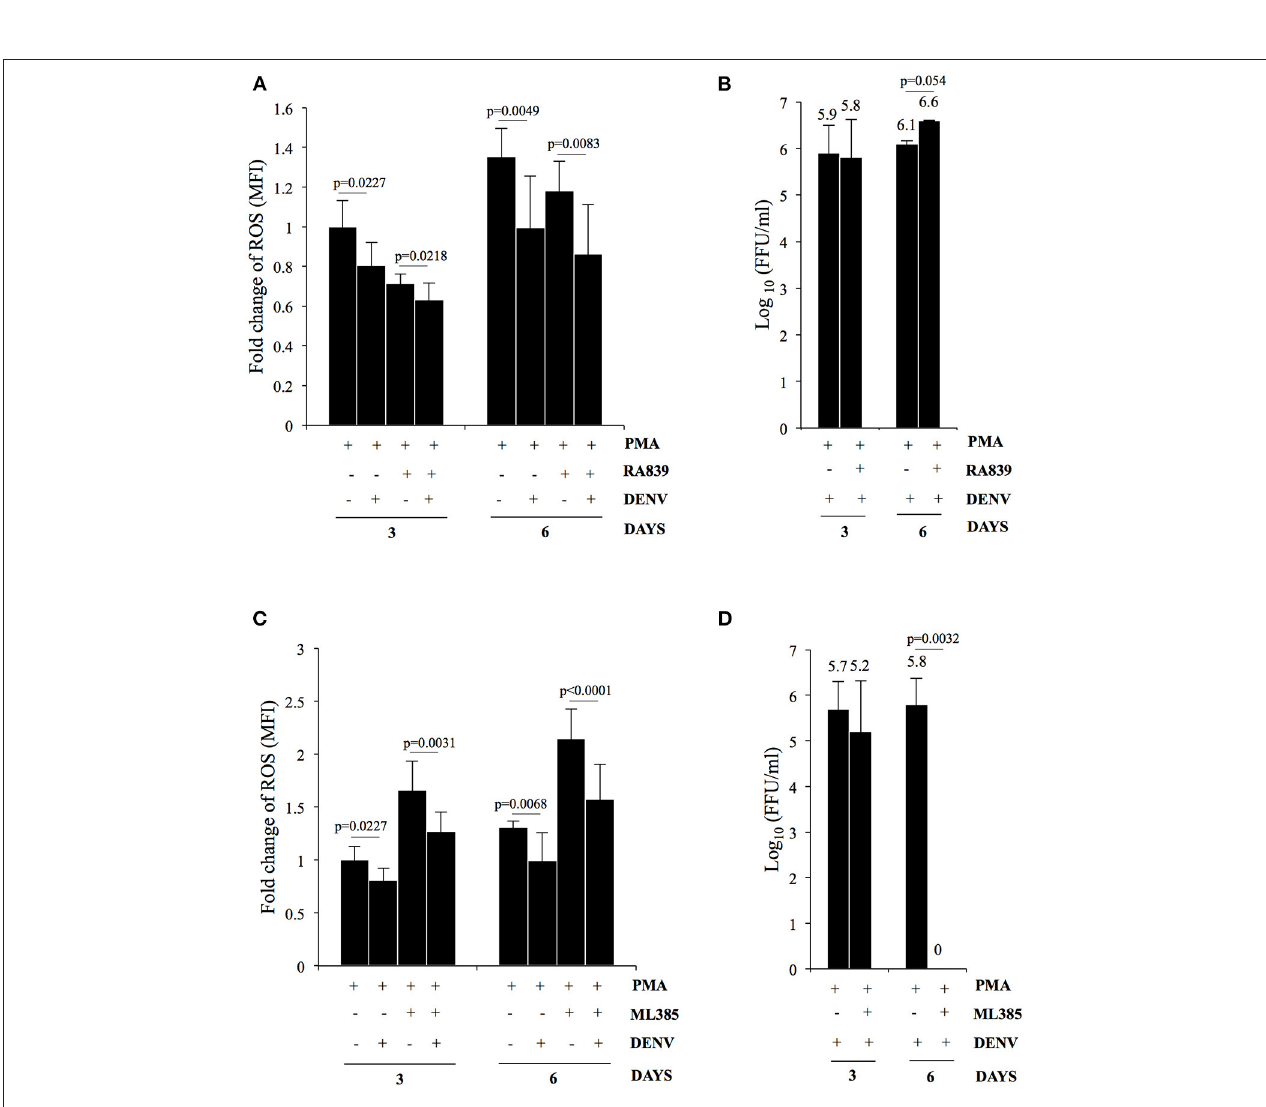
FIGURE 5 | DENV replication suppresses ROS in differentiating cells by upregulation of NFE2L2 activity. (A) K562 cells either uninfected or infected with DENV at an MOI of 1.0 were differentiated with 50nM PMA in the absence or presence of 10 µ M of RA839. At 3 or 6 days post-infection the cytosolic ROS was quantified by H 2 DCFDA staining as described above. (B) K562 cells infected with DENV at an MOI of 1.0 were differentiated with PMA in the absence or presence of 10 µ M of RA839. The supernatant was collected at 3 or 6 days post-infection and the infectious titer of secreted virus quantified by Focus-forming unit (FFU) assay. The Log 10 of the FFU/ml was calculated and plotted. (C) K562 cells either uninfected or infected with DENV at an MOI of 1.0 were differentiated with PMA in the absence or presence of 10 µ M of ML385. At 3 or 6 days post-infection the cytosolic ROS was quantified by H 2 DCFDA staining as described above. (D) K562 cells infected with DENV at an MOI of 1.0 were differentiated with PMA in the absence or presence of 10 µ M of ML385. The culture supernatant was collected at 3 or 6 days post-infection and the infectious titer of secreted virus quantified by Focus-forming unit (FFU) assay. The Log 10 of the FFU/ml was calculated and plotted. (A–D) The error bars represent standard deviation obtained from 3 independent experiments and the P -values of significance calculated by Student’s t -test are indicated.